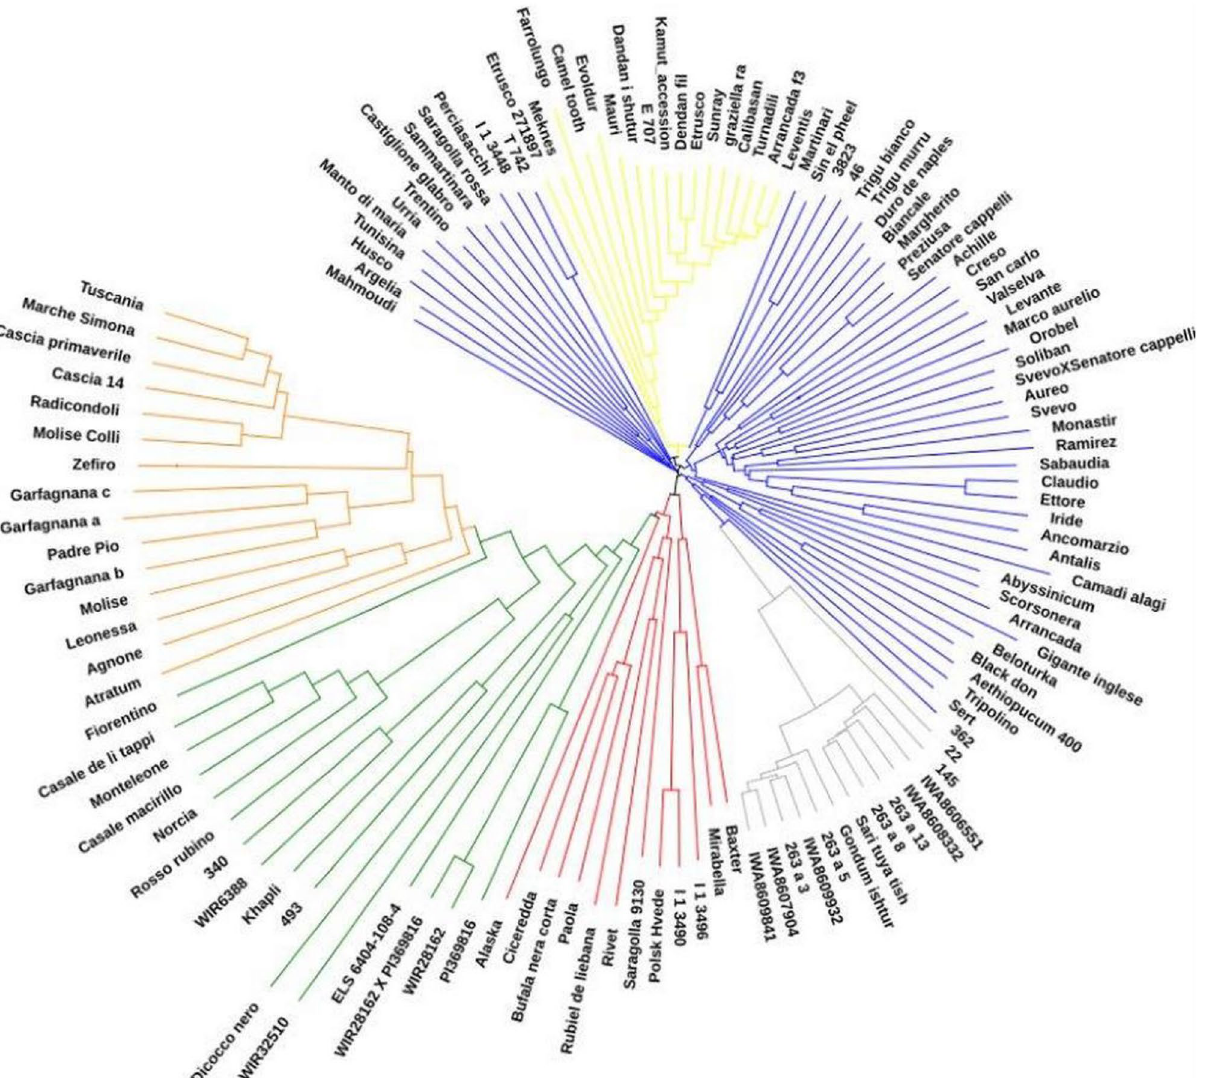
Figure 2. Unrooted tree of 127 tetraploid wheat accessions based on single nucleotide polymorphisms (SNPs) markers genetic distance and colored according to discriminant analysis of principal components (DAPC) clusters. Each tree branches color corresponds to the cluster to which the accession belongs: red for cluster 1, yellow for cluster 2, blue for cluster 3, green for cluster 4, grey for cluster 5 and orange for cluster ssp. polonicum (8 out of 13) clustered with the main group containing ssp. durum accessions (cluster 3), while the other (5) accessions were included in cluster 1, which also contained some ssp . durum accessions, along with three accessions described as ssp. turgidum. Interestingly, the 3 ssp. palaeocolchicum accessions and one of ssp. carthlicum (PI 341800) grouped in cluster 4, with ssp. dicoccum accessions . Another accession described as ssp . carthlicum (PI 70738) clustered with ssp. turanicum accessions of cluster 5. A single accession of ssp. dicoccon (Farrolungo) was included in cluster 2 with different ssp. turanicum accessions. AMOVA results for K = 6 showed a high variability within accessions (91.67% of the total variance) but confirmed a significant difference between clusters (p-value = 4.99975e−05) to which 8.33% of the total vari- ance is attributed. In the wake of such results, subsequent analyses were performed following these genetically determined clusters. Mycorrhizal status and colonization level of wheat accessions. The typical symbiotic structures of AMF, such as hyphae, arbuscules, vesicles and spores were observed under the optical microscope, for all accessions (Fig. S2). Roots colonization levels of plants were strongly dependent on the accession, with a high variability both when inoculated with F. mosseae , ranging from a minimum of 12.7% (Ramirez, ssp. durum of cluster 3) to a maximum of 84.1% (Sin El Pheel, ssp. polonicum of cluster 3), and with R. irregulare , ranging from 7.0% (Garfagnana b, ssp. dicoccum of cluster 6) to 67.7% (Soliban, ssp. polonicum of cluster 3) (Table S1). Actually, a high level of variability occurred within genetic clusters as assessed by ANOVA, which showed a